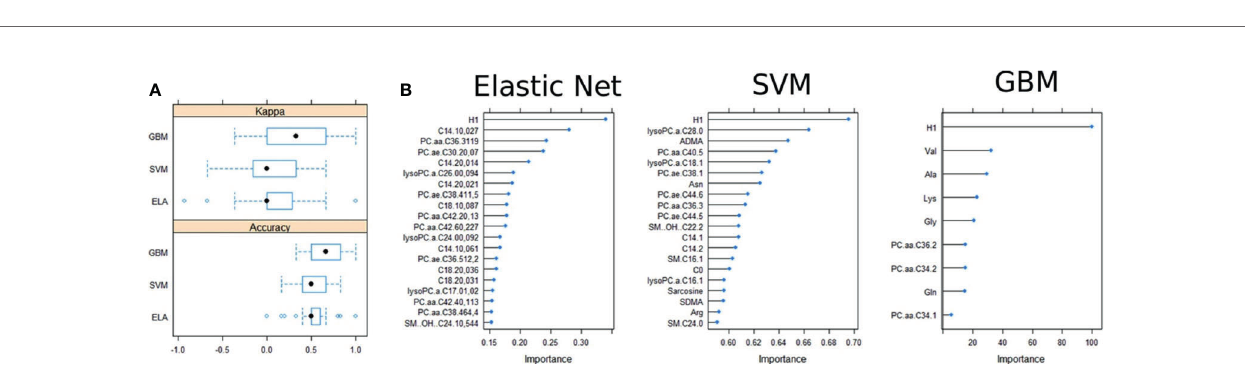
FIGURE 4 | Variable selection in the training dataset. (A) Accuracy and Kappa comparisons of the three models used in feature selection. (B) Importance of the variable selection and out-of-bag predictive performance estimation.